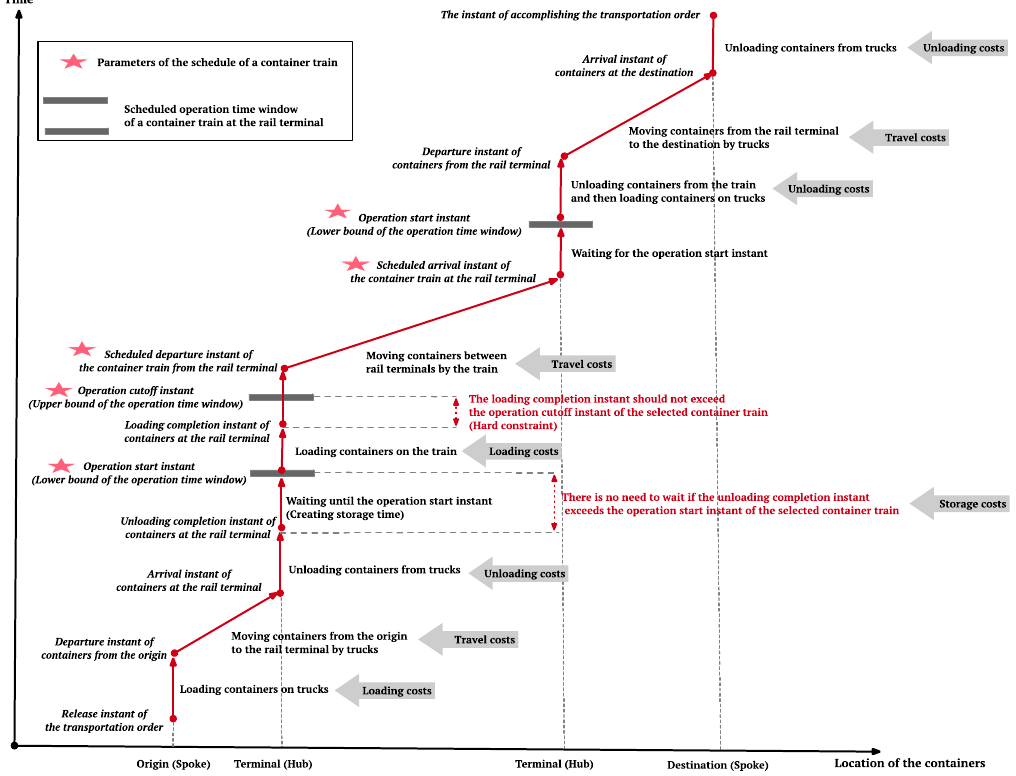
Figure 8. Transportation process integrating time-flexible container trucks and scheduled container trains in a hub-and-spoke network.